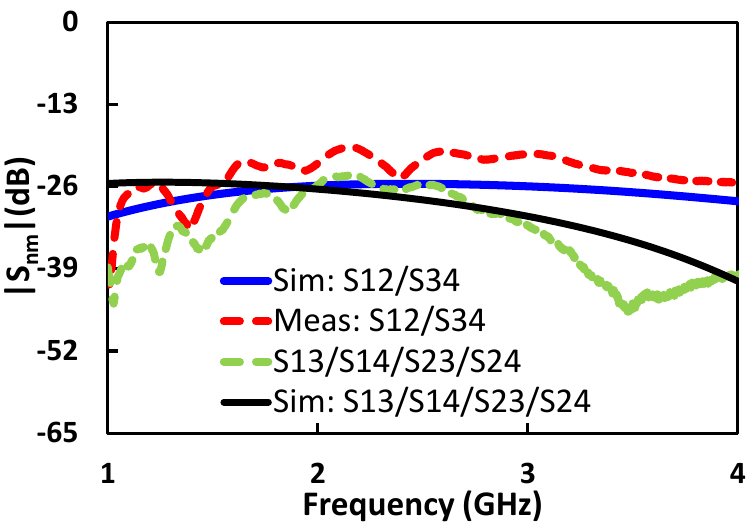
Figure 7. The isolation performance of the proposed MIMO